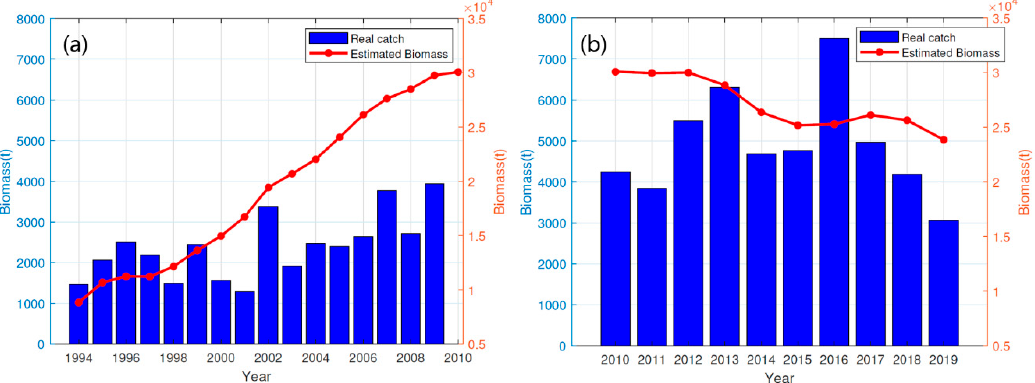
Figure 8. Estimated annual total biomass (redline) and the catch (blue bar) in the eastern coastal waters of Korea. ( a ) Between 1994 and 1998; ( b ) Between 2005 and 2009.